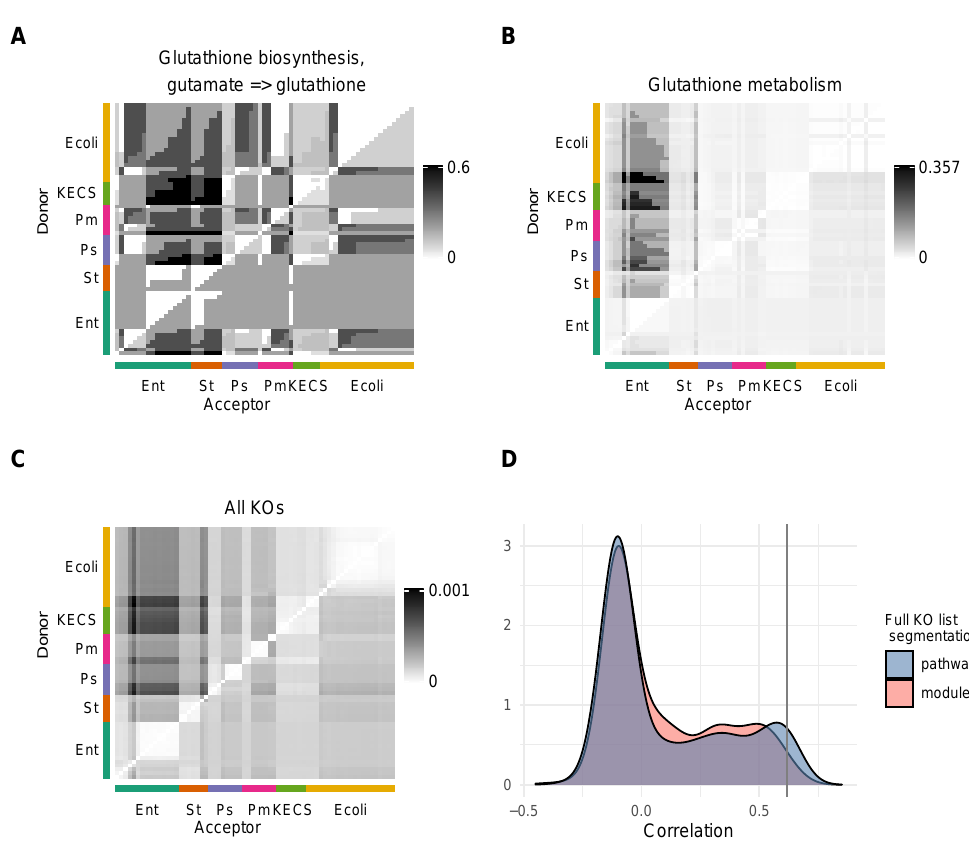
Figure 2. Heatmap of the ‘Correlation 3’ between the different strains within the groups. ( A ) The KOs selected belong to a module. ( B ) The KOs represented are part of a pathway. ( C ) All KOs were taken into account to calculate the ‘Complementarity 3’. ( D ) The density distribution of the correlations between the ‘Complementarity 3’ calculated using KOs belonging to one pathway at a time is shown in blue. In red, there is the similar calculation for modules. The vertical line represents the correlation using all available KOs. Using the pathways for the segmentation of the KO vectors yields the highest